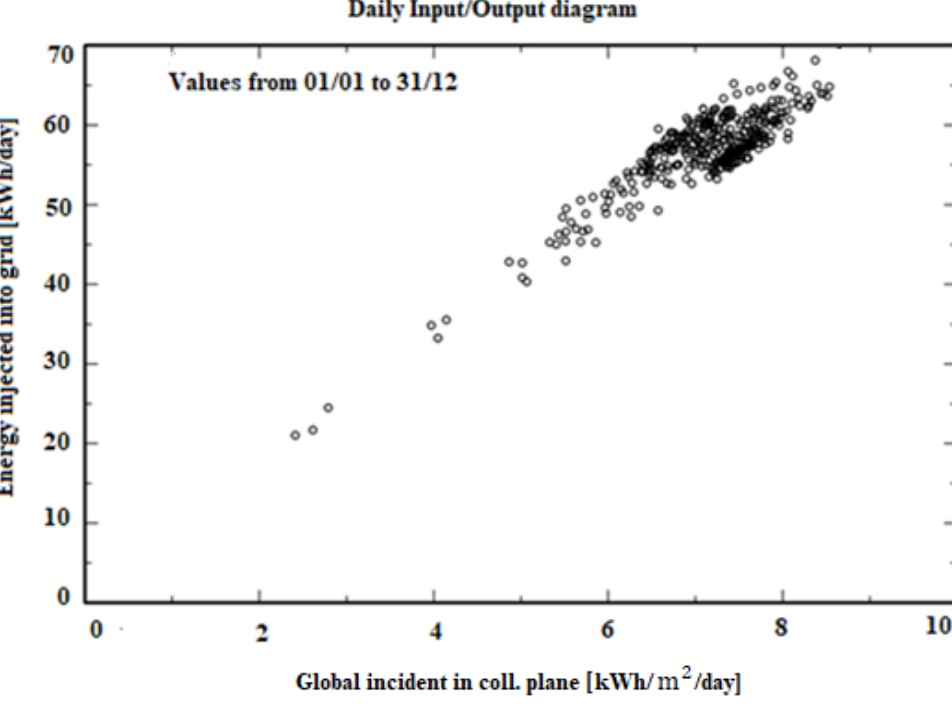
Figure 7. Daily input/output diagram for the Meybod area.